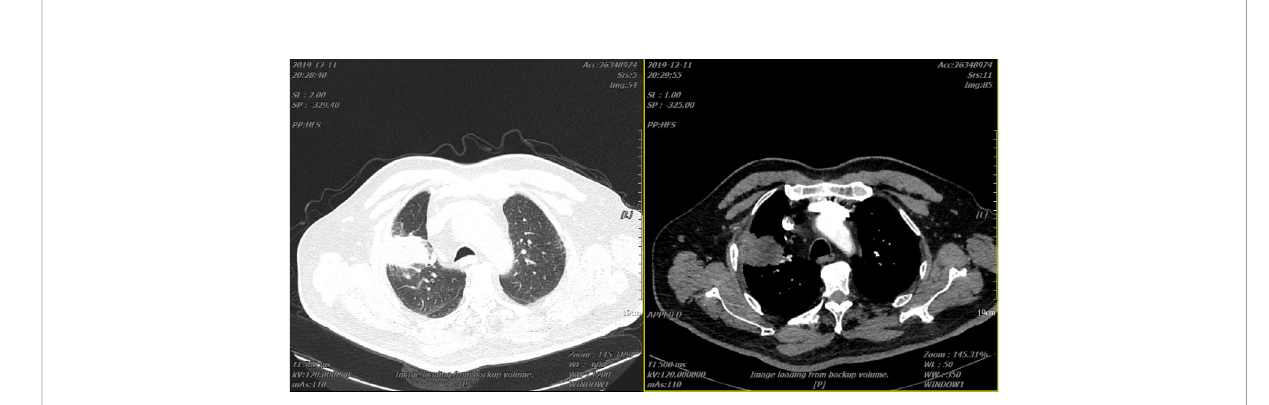
FIGURE 3 Two representative CTs of the patient in 21 December 2019.